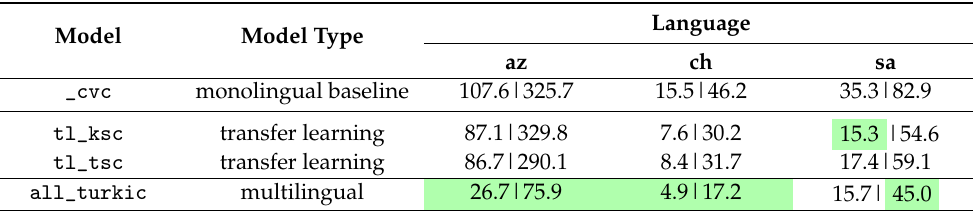
Table 9. The CER (%)|WER (%) results of monolingual models, models built using transfer learning, and all_turkic for Azerbaijani, Chuvash, and